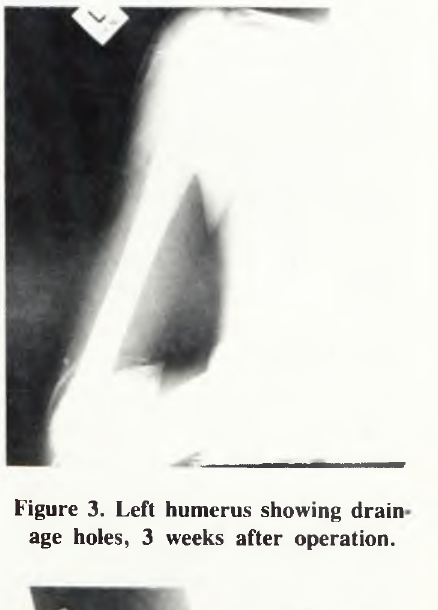
Figure 3. Left humerus showing drain age holes, 3 weeks after operation.